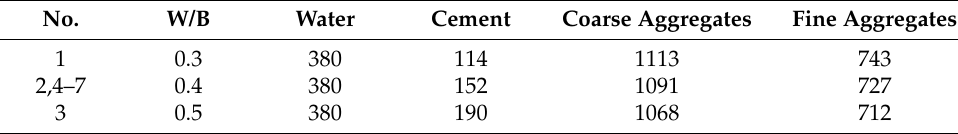
Table 3. Mix proportions of concrete specimens (kg/m 3 ).